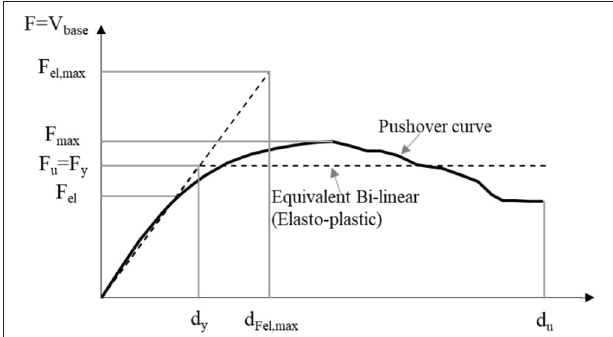
FIGURE 11 | Parameters for the definition of the behavior factor q (F base shear, d displacement at a control point).